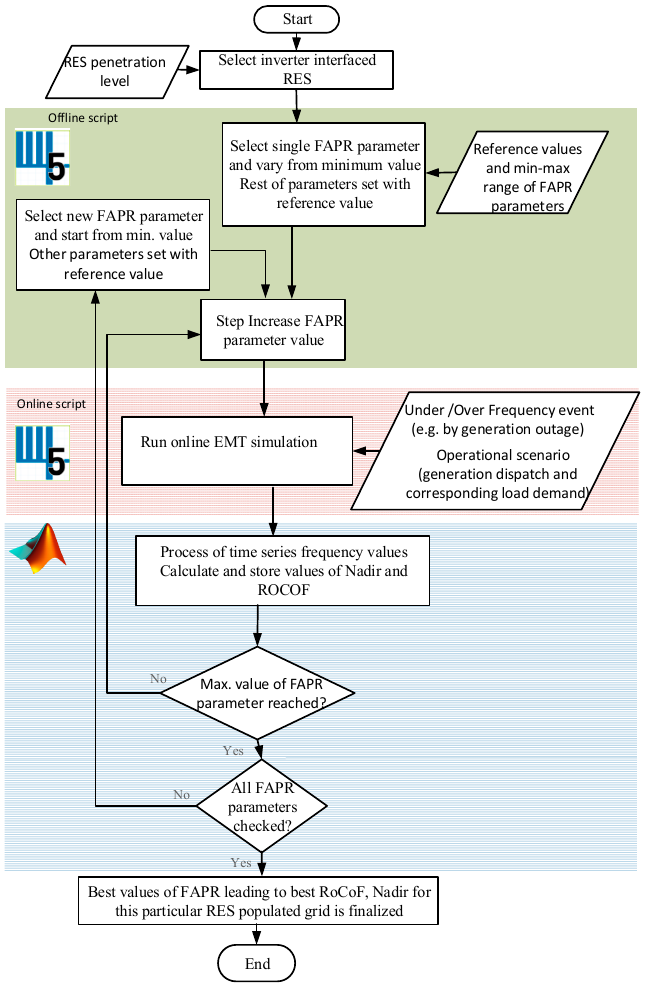
Figure 9. Procedure for parametric sensitivity-based tuning of FAPR